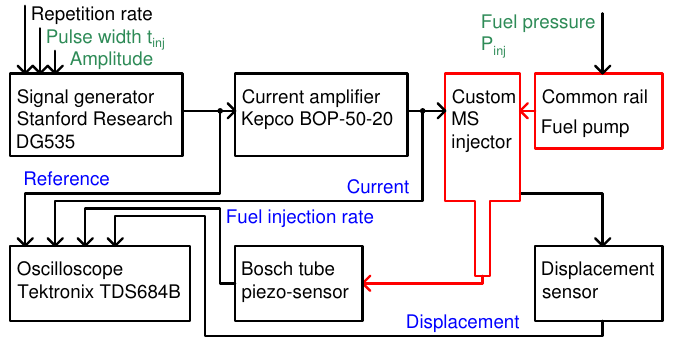
Figure 4. Experimental setup scheme with signals routing. The signal acquired in one repetition period are in blue color, while controllable parameters are in green color.